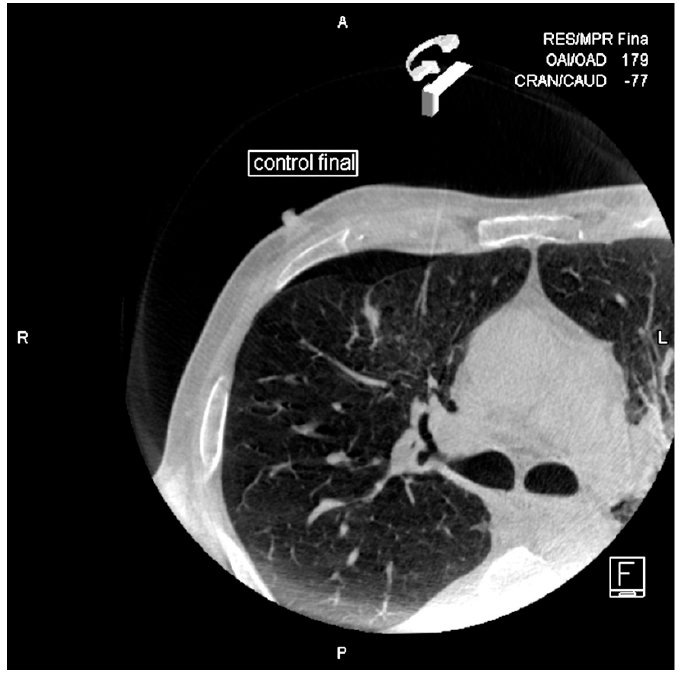
Figure 5. Small pneumothorax is observed after removing the needle.